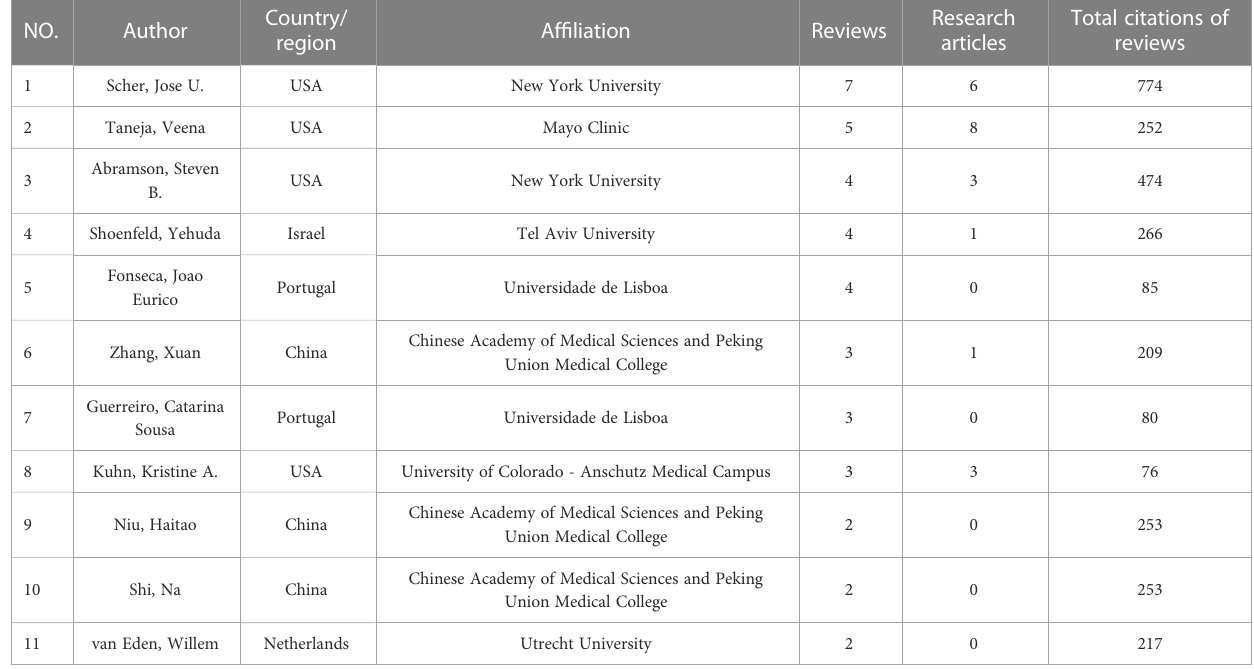
TABLE 2 The top authors with the most reviews and total citations.